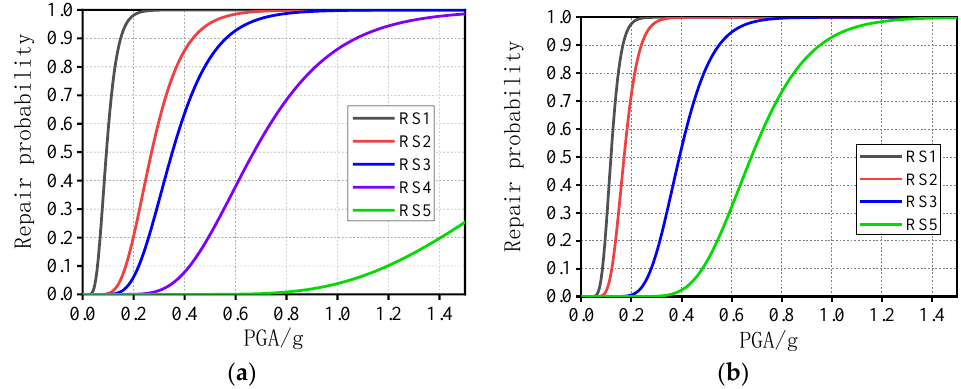
Figure 8. Structural Fragility Curves: ( a ) CoSPSW, ( b ) SPSW.